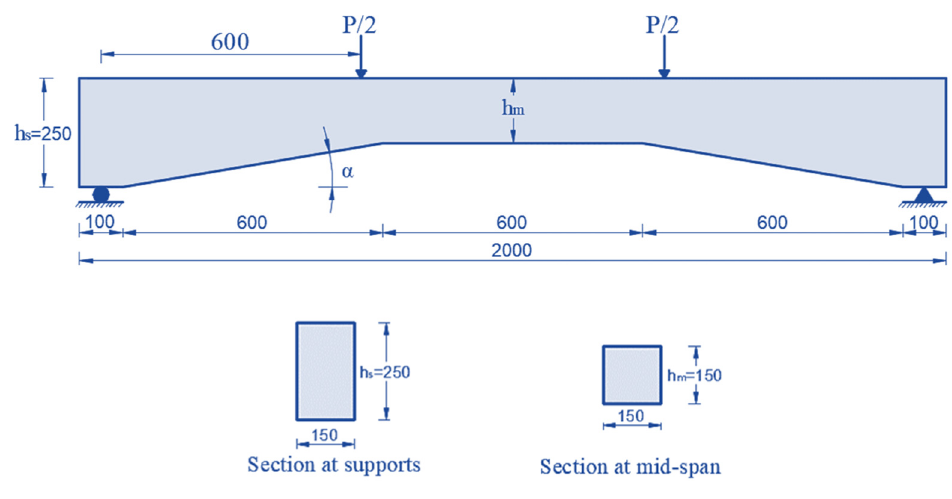
Figure 2. Haunched beams properties.